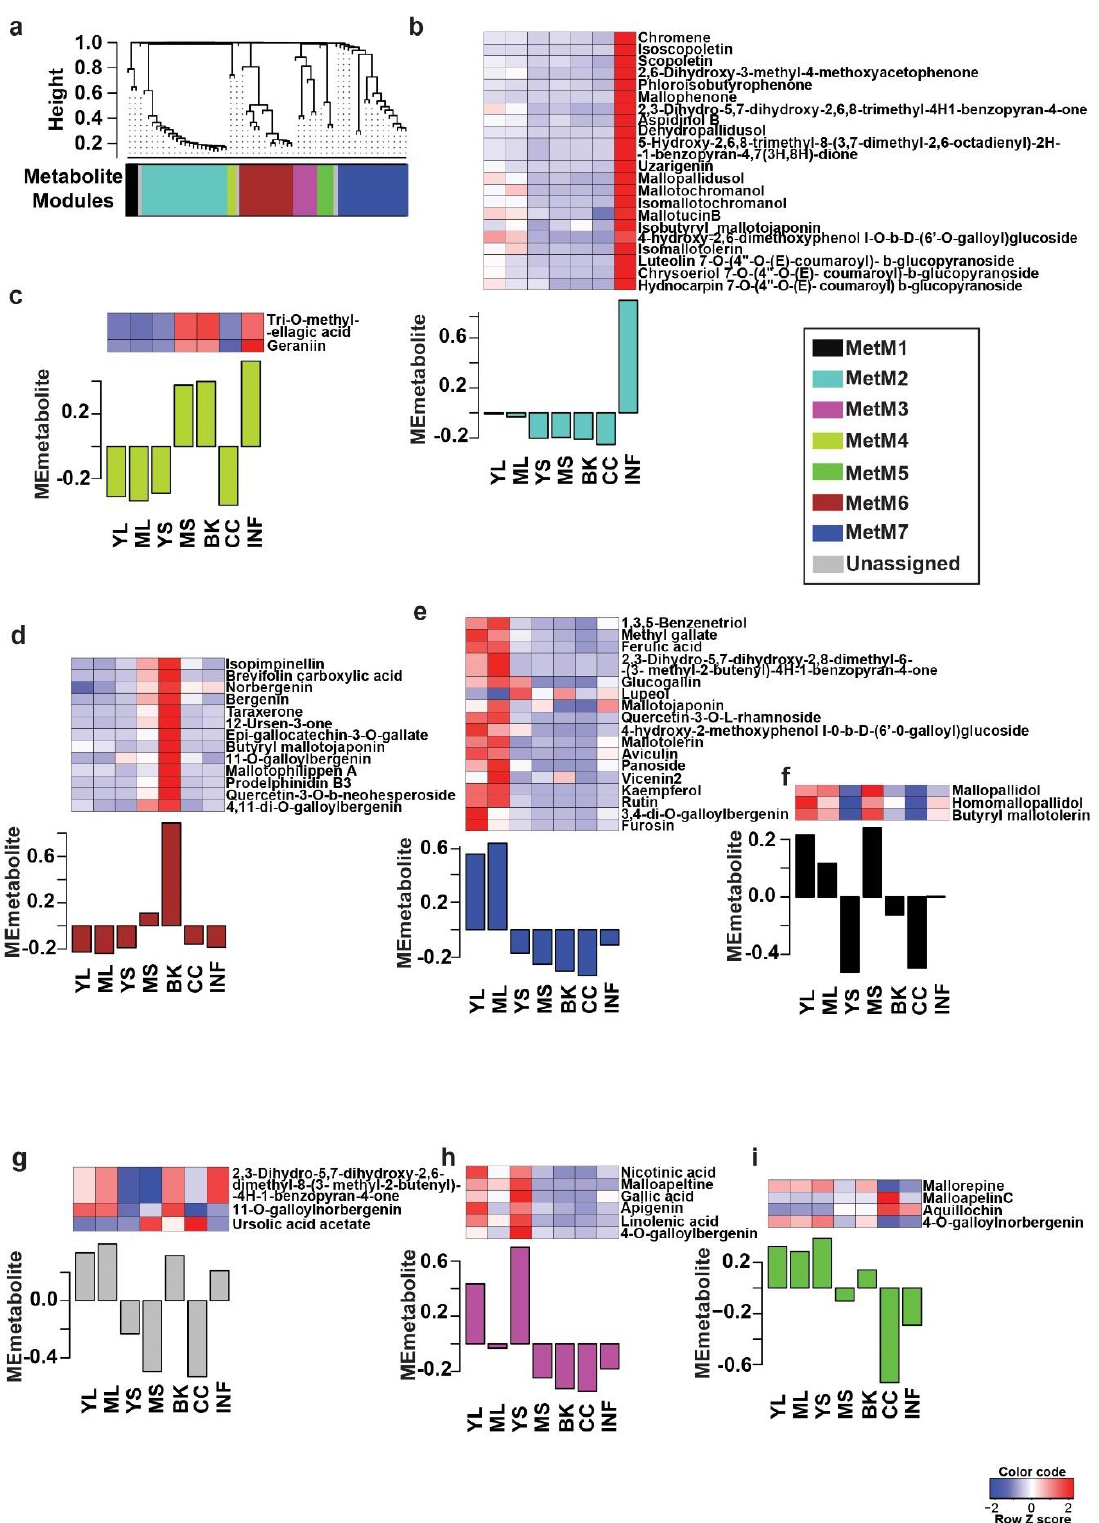
Figure 4. WCNA analysis and accumulation pattern of MS 2 confirmed the metabolites in Mallotus japonicus . ( a ) The dendrogram represents 69 MS 2 -confirmed metabolites used for WCNA analysis and clustering of module eigenmetabolites; ( b – i ) The bar plots show the module eigenmetabolite of MS 2 -confirmed metabolites. The relative accumulation levels of metabolites included in each module are also shown by the heat maps above each bar plot. Abbreviations: ML: Mature leaf, YS: Young stem, YL: Young leaf, CC: Central cylinder, MS: Mature stem, INF: Inflorescence, and BK: Bark.